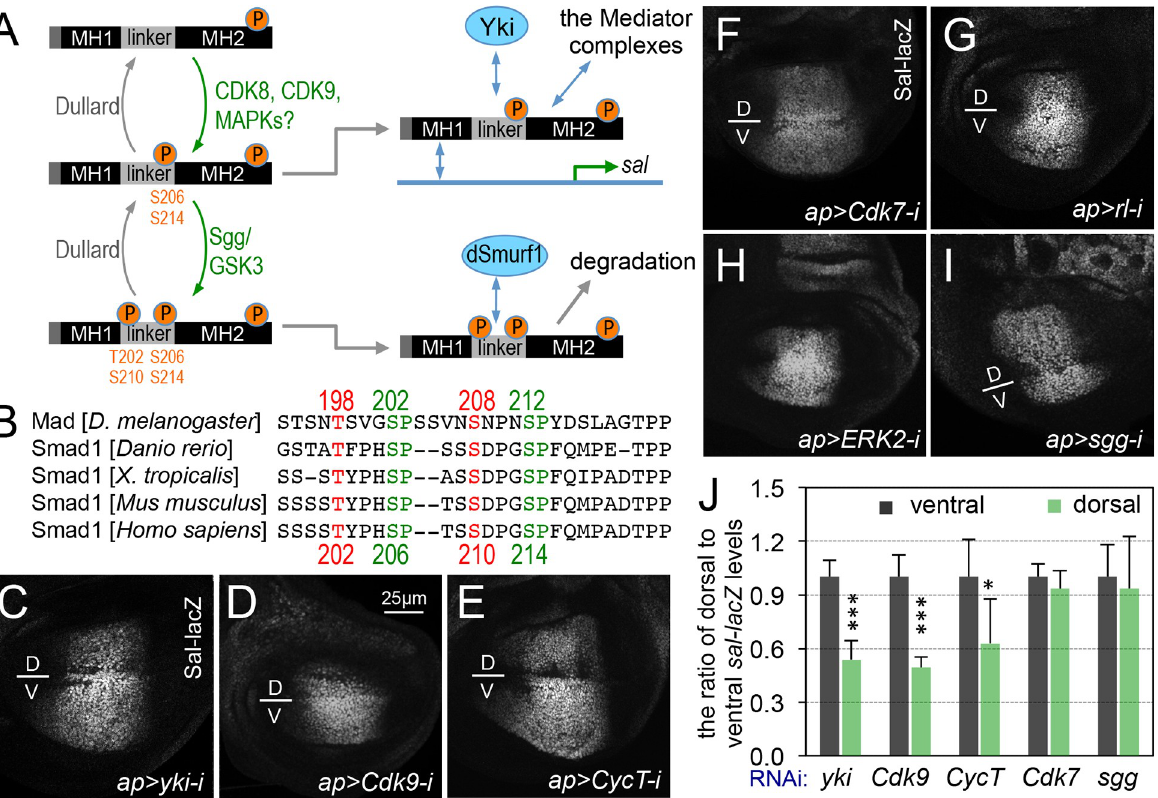
Fig 8. Validation of additional transcriptional cofactors for their roles in regulating Mad-dependent transcription. (A) Model: linker region of pMad may be phosphorylated by CDK8, CDK9, or MAPKs as priming kinase recruiting Yki/YAP binding to pMad to drive target gene, such as sal transcription; and further phosphorylation by Sgg/GSK3 at the linker region may switch the binding to dSmuf1 and causes pMad degradation. (B) Sequence alignment of part of the Mad/Smad1 linker region from different species showing the conservation of the potential phosphorylation sites by CDKs, MAPKs, and GSK3. Representative confocal images of anti- β -Gal staining of wing discs of the following genotypes: (C) ap-Gal4 , sal-lacZ/ +; UAS-yki-RNAi/+ ; (D) ap-Gal4 , sal-lacZ/UAS-Cdk9-RNAi ; (E) ap-Gal4 , sal-lacZ/+; UAS-CycT-RNAi/+ ; (F) ap-Gal4 , sal-lacZ/UAS-Cdk7-RNAi ; (G) ap-Gal4 , sal-lacZ/+; UAS-rl-RNAi/+ ; (H) ap-Gal4 , sal-lacZ/+; UAS-ERK2-RNAi/+ ; and (I) ap-Gal4 , sal-lacZ/UAS-sgg-RNAi . Scale bar in D: 25 μ m. (J) Quantification of Sal-lacZ expression. The grey columns represent the average of Sal-lacZ expression in the ventral compartment of the indicated genotypes, and light green columns represent the measurements in the corresponding dorsal compartments. N = 5 for the quantification of sal-lacZ expression after depleting Yki, Cdk9, or CycT in the dorsal compartment; N = 3 for the quantification of sal-lacZ expression after depleting Cdk7 or Sgg in the dorsal compartment. At least five wing discs were examined for depletion of Rl (G) and ERK2 (H), and the represented images were